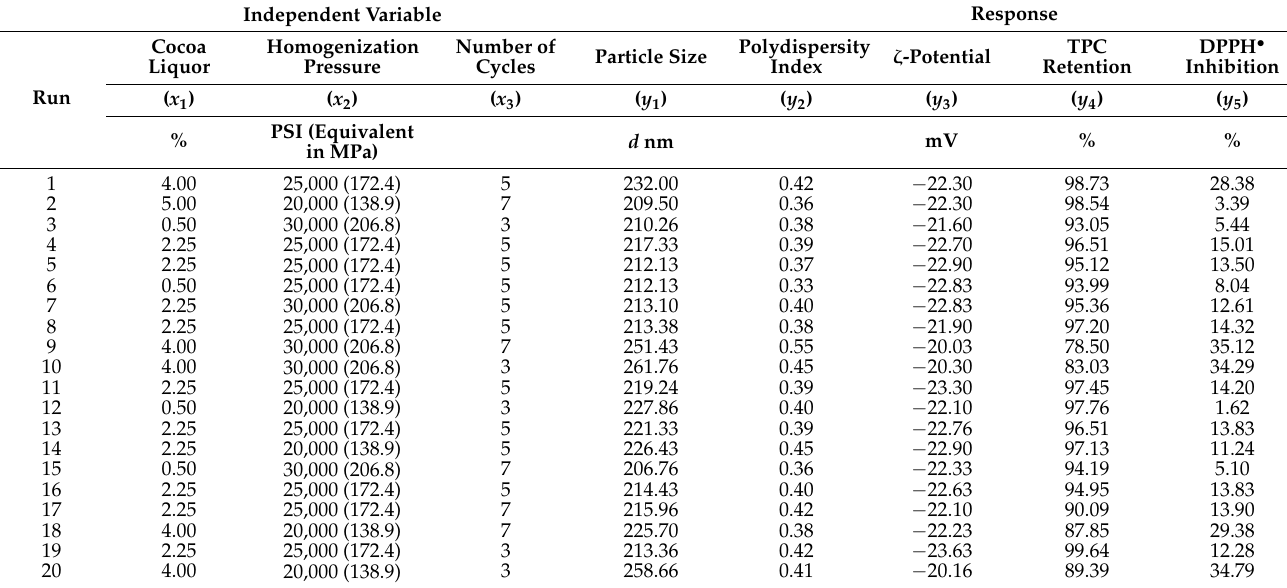
x : represents the independent variables plotted on the x -axis; y : represents the response plotted on the y -axis. Response is the mean value of three replicates. TPC = Total Polyphenol Content; DPPH • = 1-DiPhenyl-2-PicrylHydrazil radical; PSI: Pounds per Square Inch unit; MPa: MegaPascal